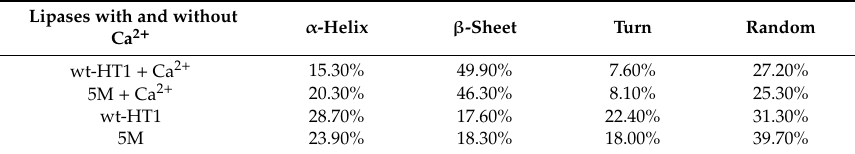
Table 3. Melting temperature point (T m ) of wt-HT1 and 5M mutant lipases with and without calcium ion using Circular Dichroism.